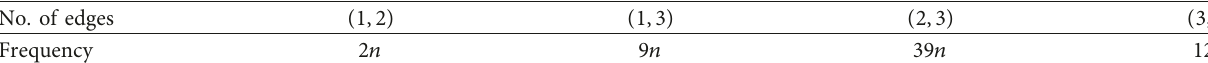
Figure 2: Crosslinked phenol-formaldehyde (PF) resin structure. Table 2: Degree-based edge partition for